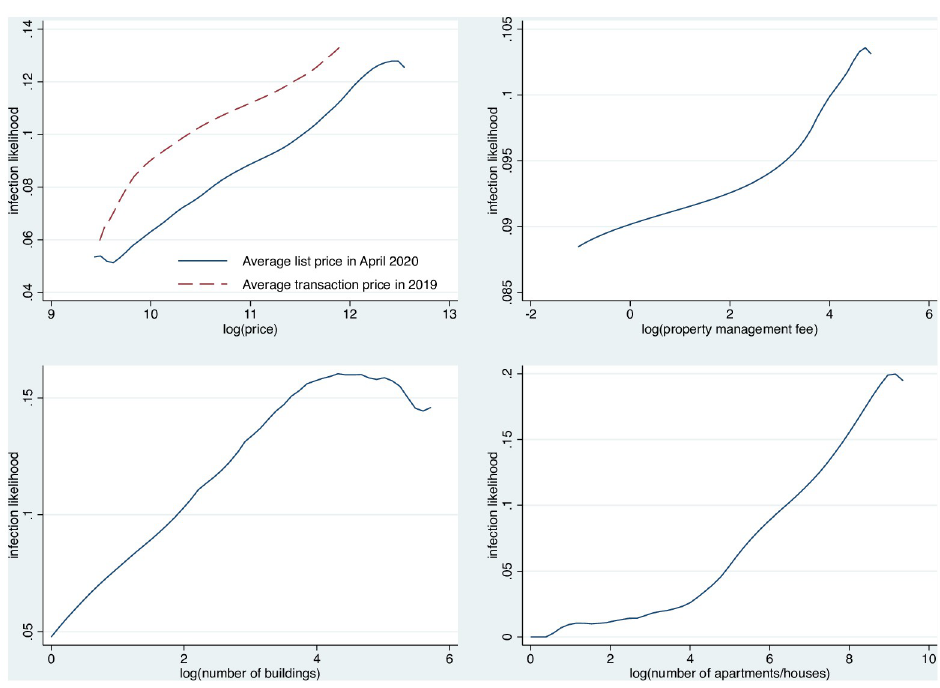
Fig 3. Relationship between infection likelihood and housing price, property management fee, and neighborhood size. Note: The relationships are estimated through kernel-weighted local smoothing.